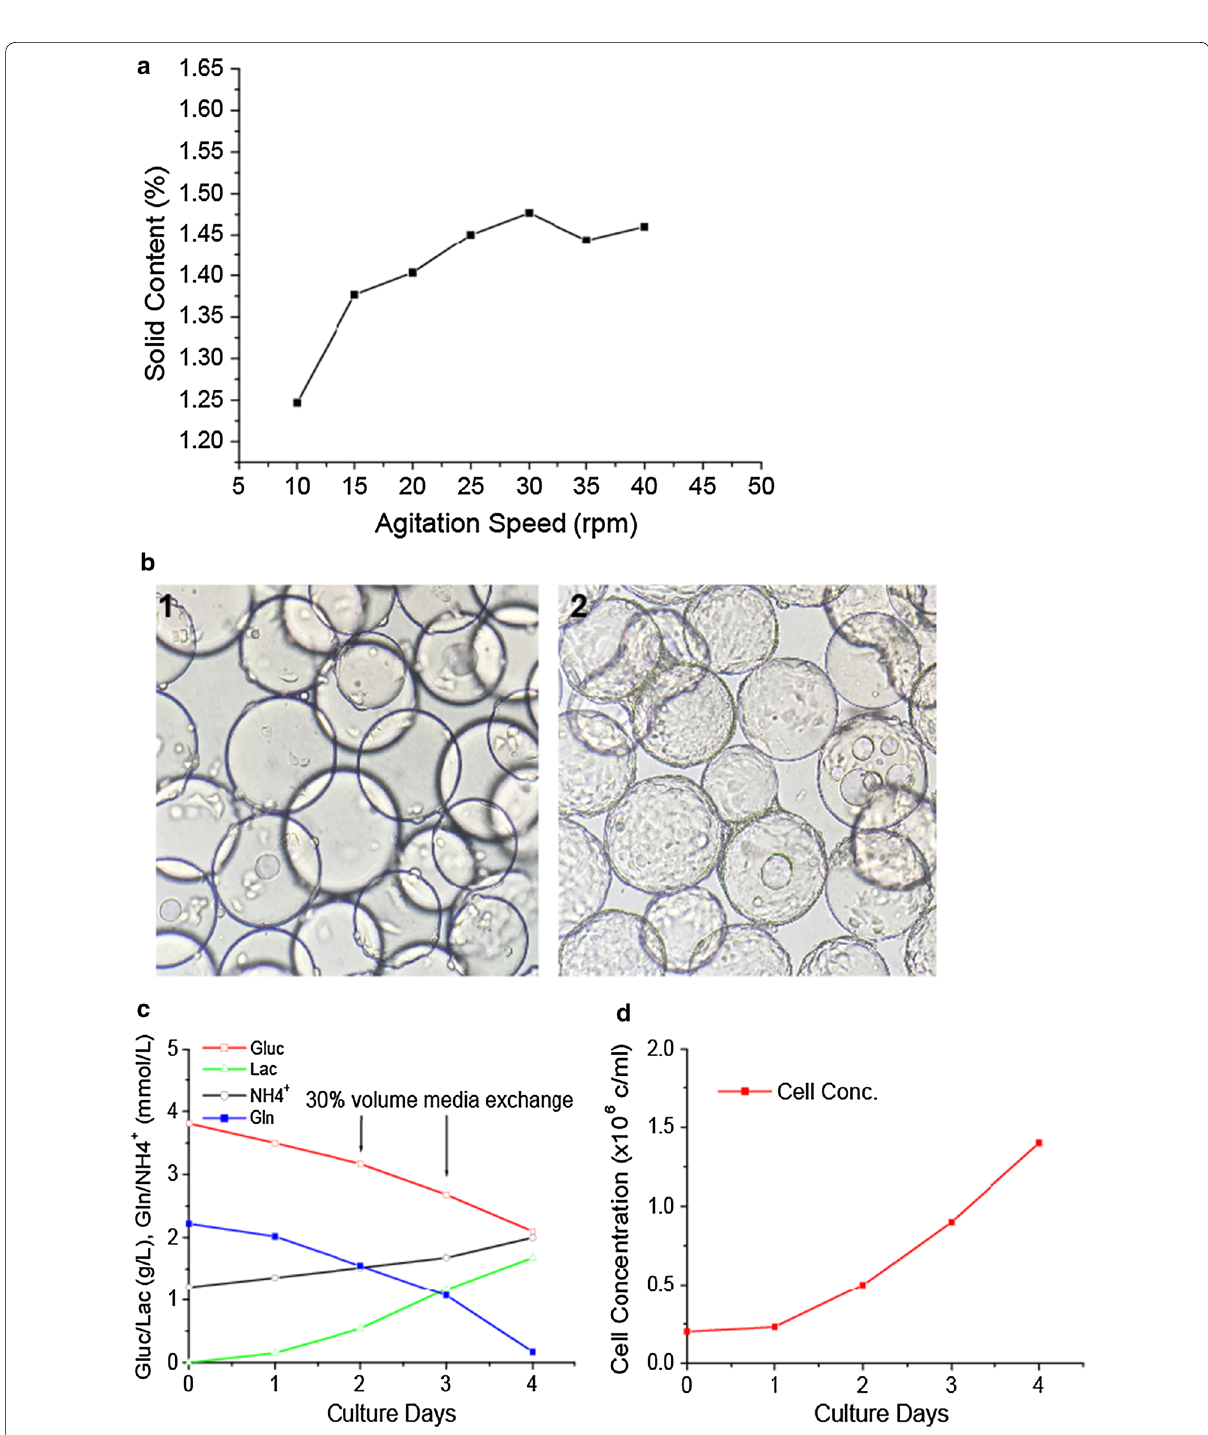
Fig. 6 HEK293T growth in XDR-50 bioreactor. a Minimum stirring speed determination of XDR50 for microcarrier homogeneous mixing. b HEK293T cell growth pictures on day 0 4 h and day 4. Some microcarrier aggregates can be found on day 4. c Glucose, lactate, and glutamine, NH 4 + profiles of HEK293T cells grown in XDR50. d HEK293T cells growth concentration curve in XDR-50